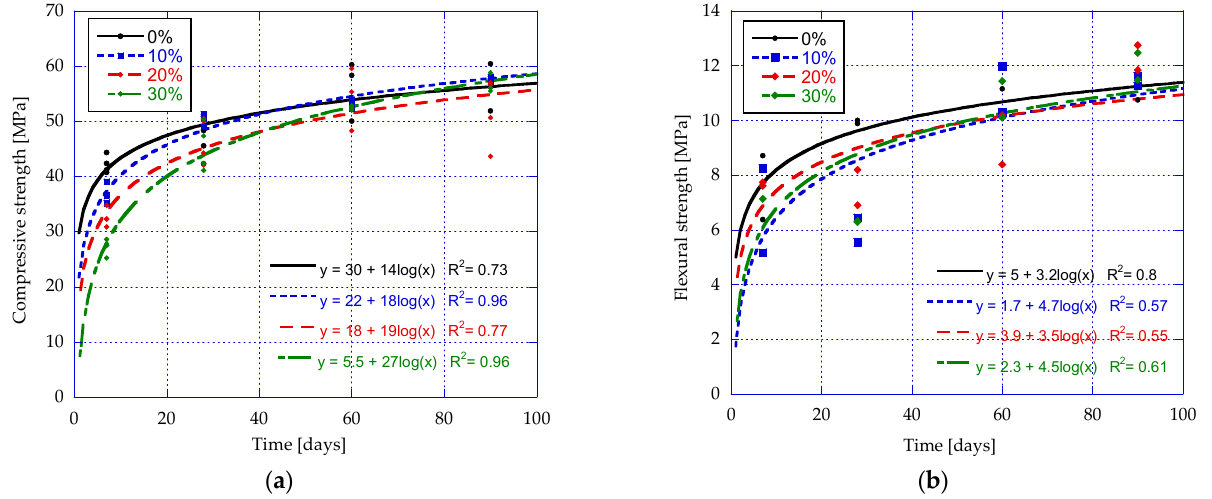
Figure 9. Compressive strength ( a ) and flexural strength ( b ) of mortars with various cement replacements by cupola slag.